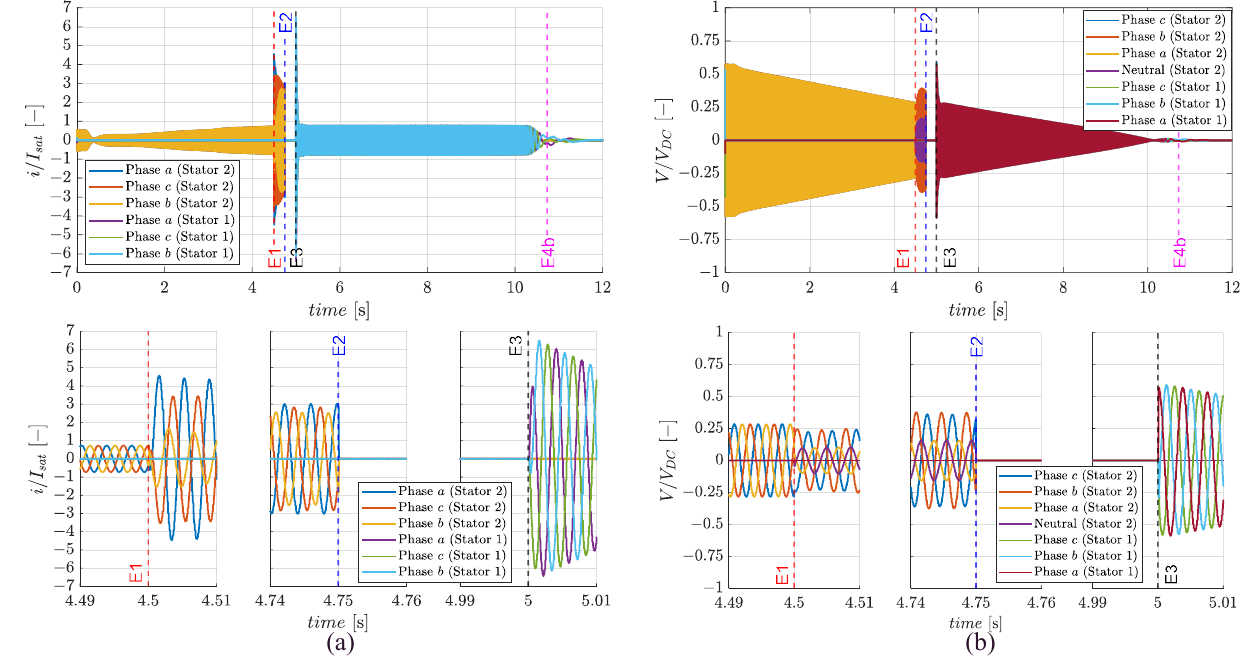
Figure 18. FEPS response in flight termination/landing with phase-to-ground fault on stator 2 (E1, E2, E3 and E4 defined in Section 3.1): stator 2 currents ( a ) with I sat = 46 Arms; stator 2 voltages ( b ) with V DC = 36